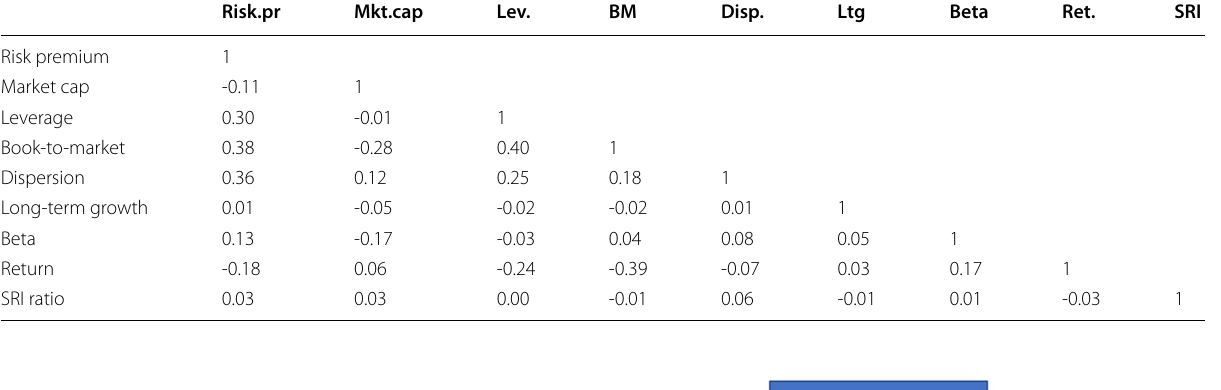
Table 7 Correlations between continuous variables Risk.pr